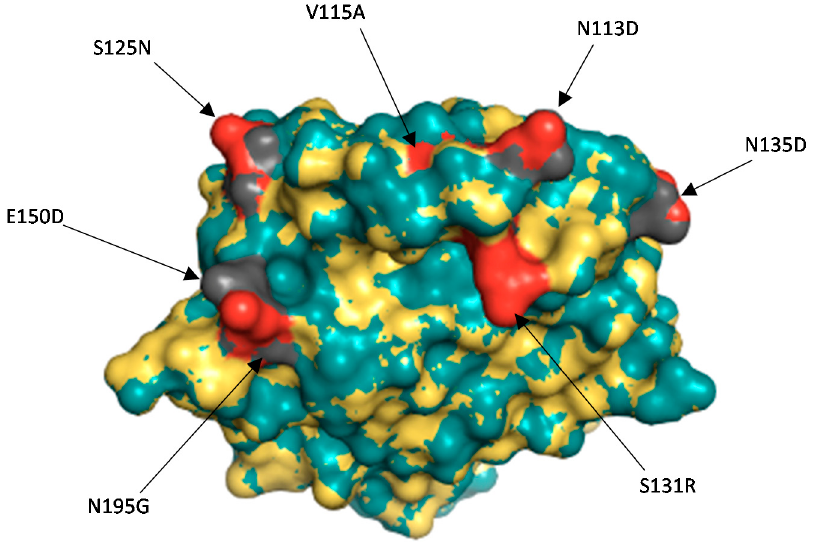
Figure 4. Surface representation of the VP8* protein of Rotarix ® and the divergent study strain UFS- NGS-MRC-DPRU4749. The superposition of the two structures has the root square mean deviation of 0.048 Å. Rotarix ® structure is represented by the teal colour whereas the Zambian P[8] strain is indicated in yellow. The red colour represents the amino acid changes observed on the Zambian study strain as compared to Rotarix ® vaccine strain in grey.